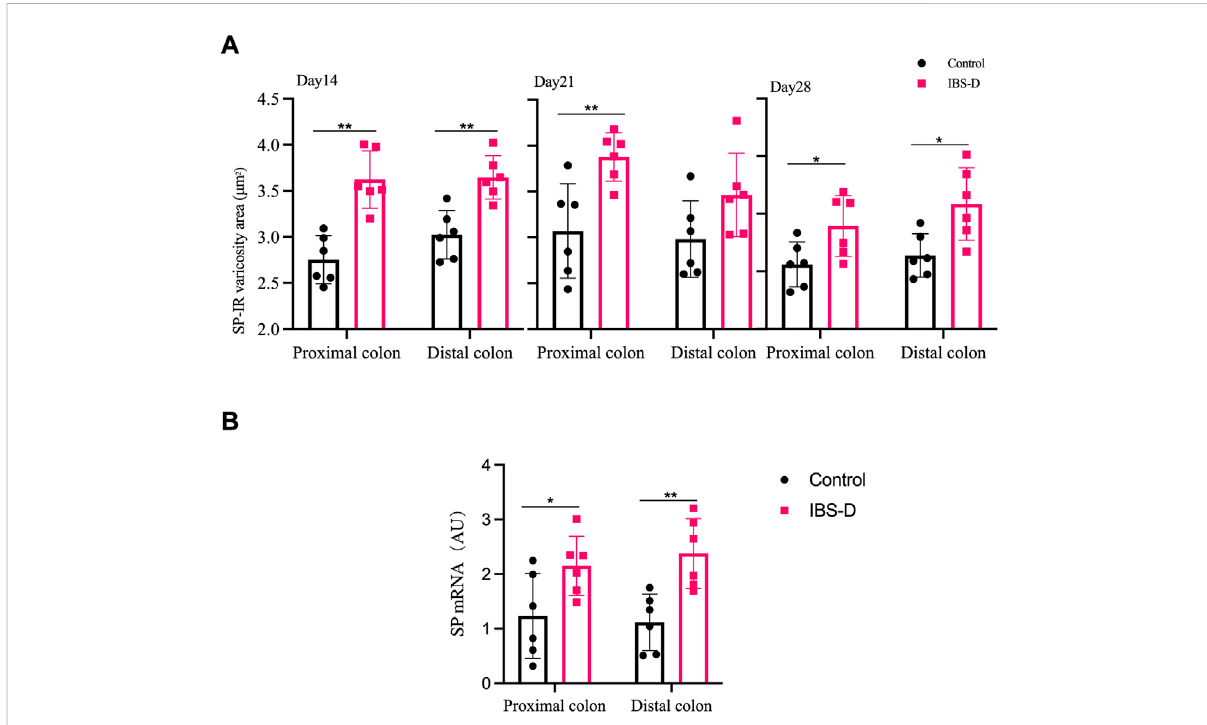
FIGURE 4 (A) SP-immunoreactive varicosities in the distal and proximal colon. (B) SP mRNA expression in model groups. RNA was isolated with TRIzol reagentandqRT-PCRwasutilizedtoanalyzethegeneexpressionofSP.TheGAPDHgenewasde fi